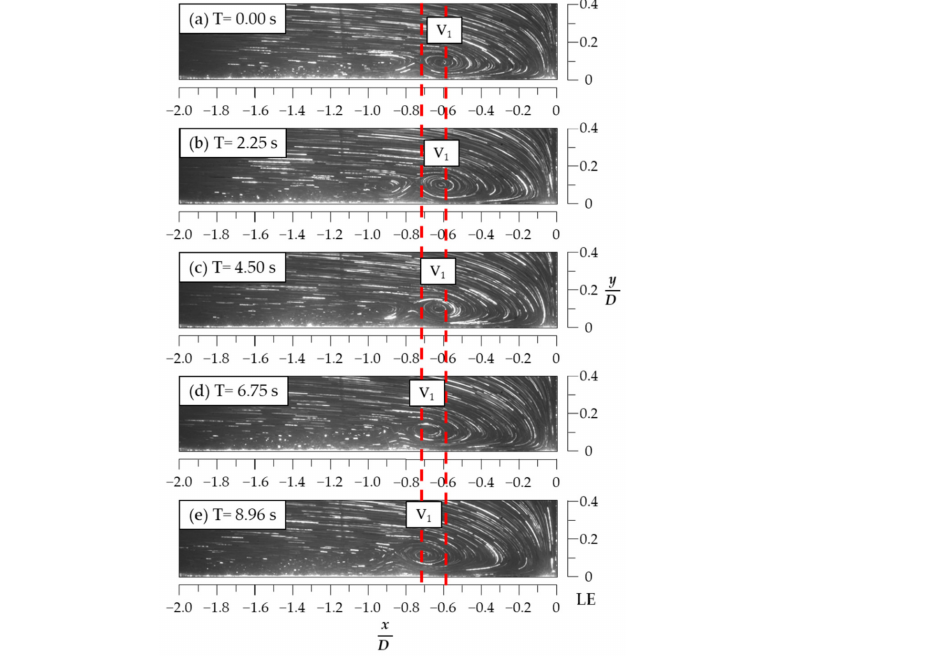
Figure 8. Time-series flow visualization of the HSV’s kinematic mode: “oscillation with a small displacement” in the z = 0 cm plane when H / D = 1.5. The two red dashed lines indicate the oscillation range of the core of the HSV closest to the LE (labeled V 1 ) between x / D = − 0.59 and − 0.72.